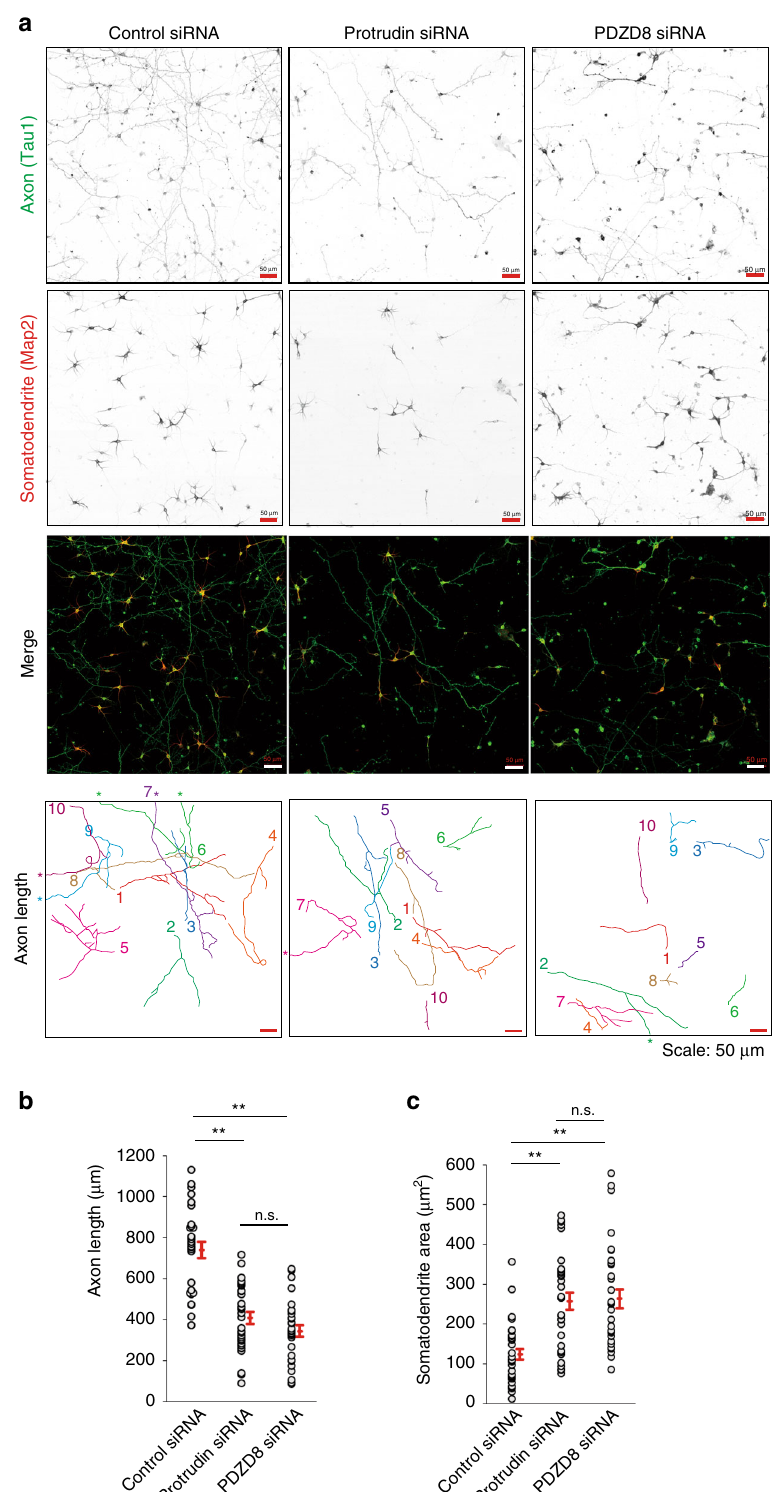
Fig. 8 Effects of protrudin and PDZD8 on neuronal polarity. a Mouse primary cortical neurons transfected with control, protrudin, or PDZD8 siRNAs were cultured in vitro for 5 days, fi xed, stained with antibodies to the axonal marker Tau1 and to the somatodendrite marker Map2, and observed with a confocal fl uorescence microscope. Axons were traced and are distinguished by number and color for measurement of their length (lowest panels). Asterisks indicate axons that extend beyond the area shown. Scale bars, 50 µ m. b , c Axon length ( b ) and somatodendrite area ( c ) determined from images as in a with the use of the ImageJ-based program Fiji. Data are means + SE for 31 to 33 independent cells. * P < 0.05, ** P < 0.01 (Kruskal – Wallis test followed by the Steel-Dwass multiple comparison test). We repeated all experiments at least three times independently with similar